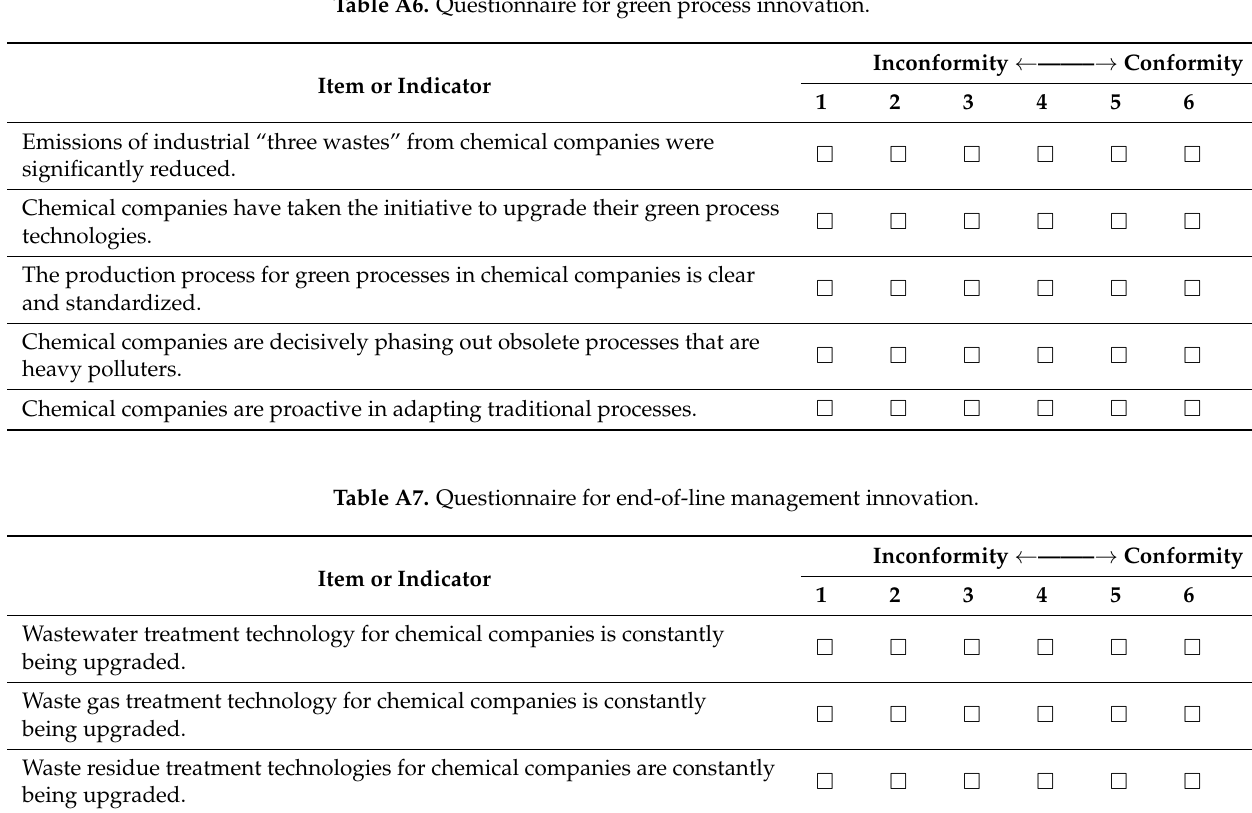
Table A6. Questionnaire for green process innovation. Item or Indicator